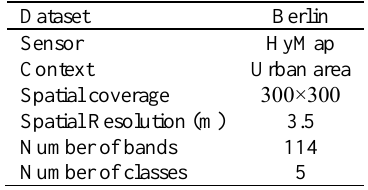
Table 1. The main characteristics of the Berlin